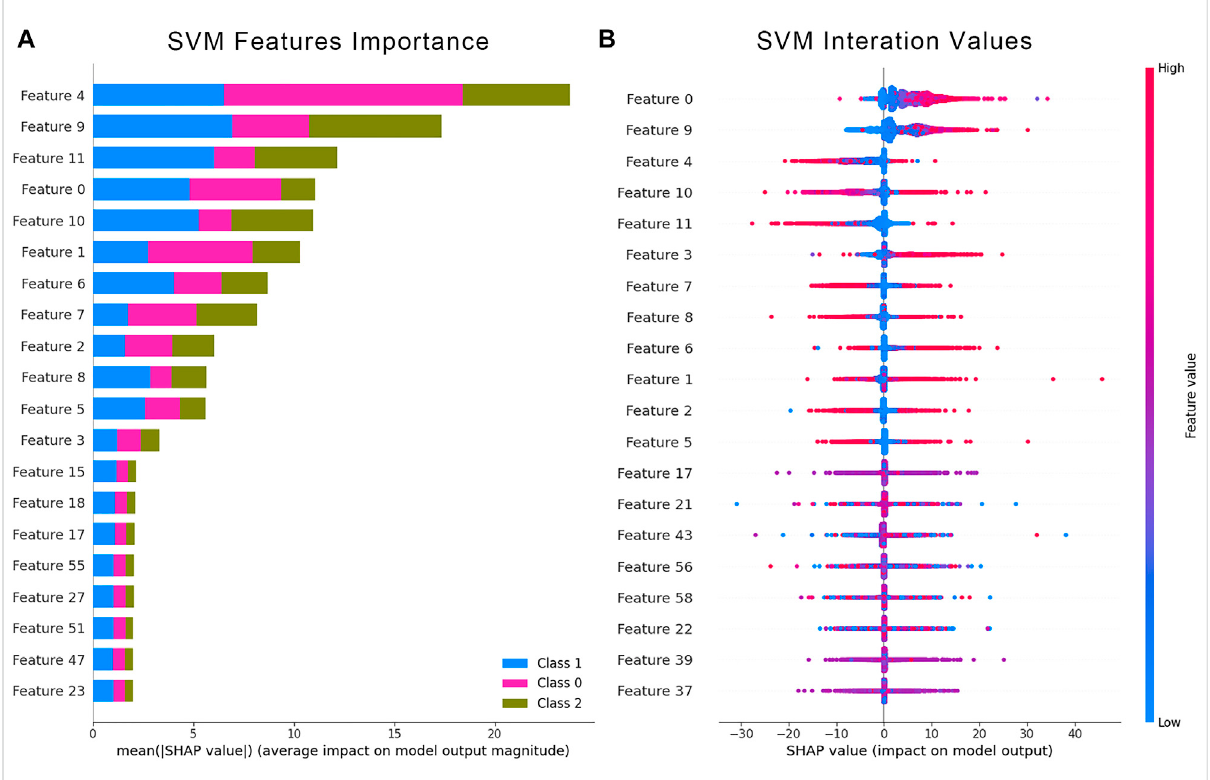
FIGURE 11 Quanti fi cation of feature impact on prediction through analysis of Shapley additive explanations (SHAP) values of the 20 most impactful features. (A) Averaged Shapley values of features with higher contribution indicate an average effect of these features on the output amplitude. (B) The scatter plot represents the distribution of Shapley values and the effect on the model output of all test